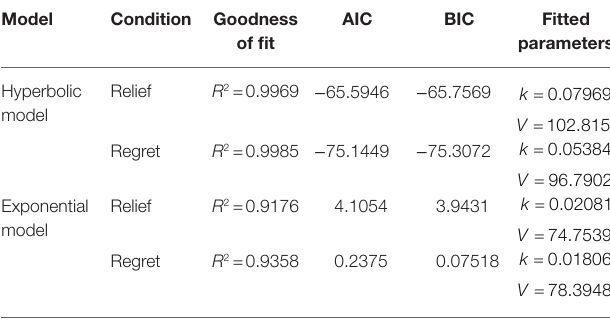
TABLE 1 | The estimation results of RF and RT conditions from the discounting models.